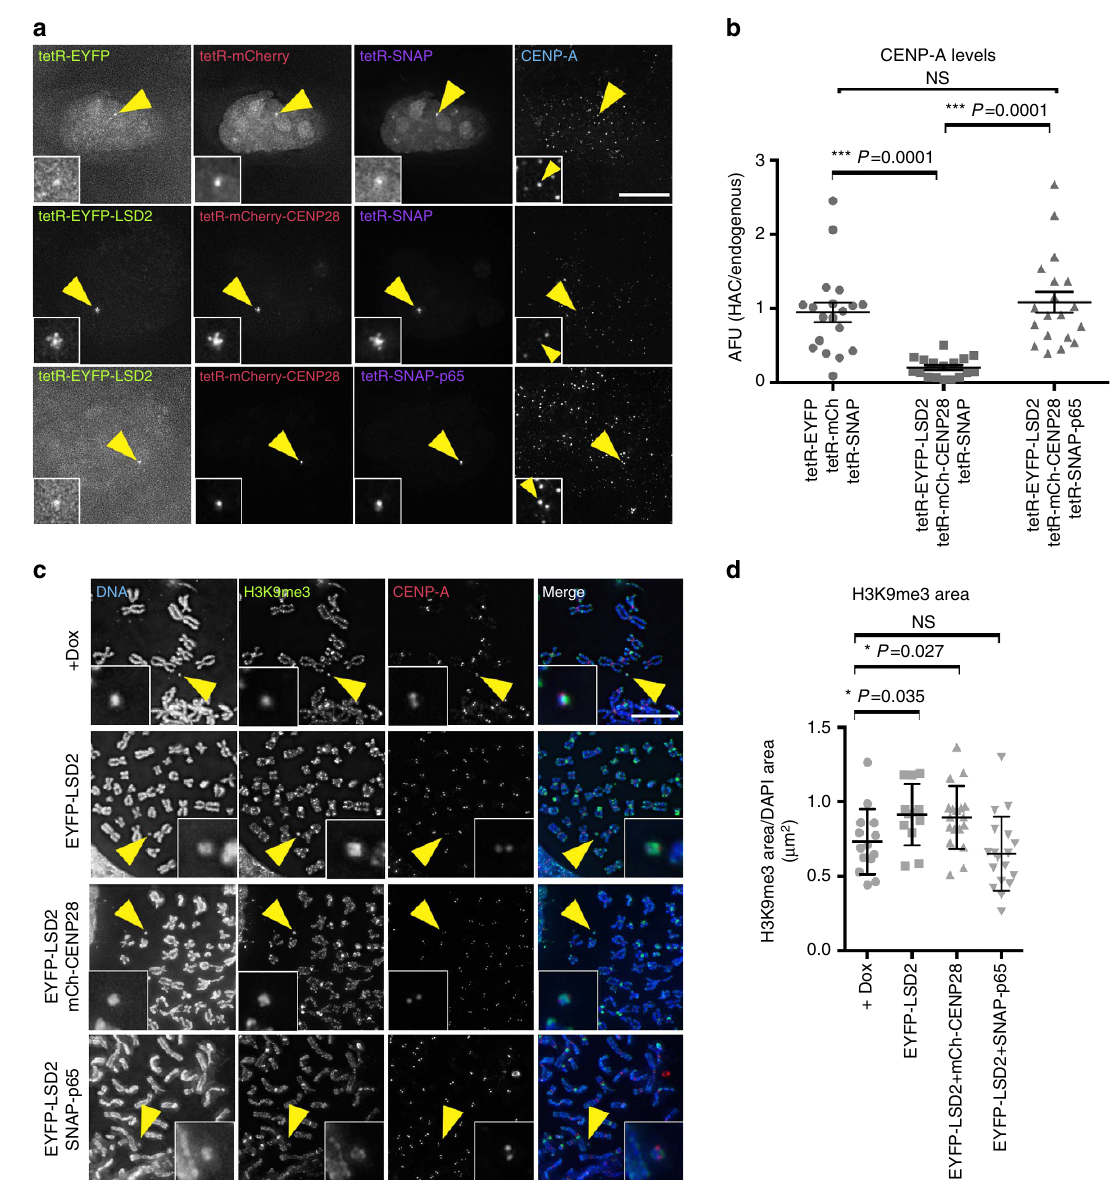
Figure 8 | H3K4me2 and H3K9ac maintain the epigenetic signature of centrochromatin. ( a ) Representative images of 1C7 cells expressing the indicated tetR-fusion proteins for 48h. The tetR-SNAP fusion proteins were detected by incubating cells with SNAP-Cell 647-SiR substrate (panel 3) and CENP-A was detected with Alexa-405-coupled antibodies (panel 4). ( b ) Quantification of fluorescence signals of HAC-associated CENP-A staining in individual cells transfected with the indicated tetR-fusion constructs. Values for the HAC-associated CENP-A were normalized for the mean of CENP-A signals on endogenous chromosomes. ( c ) Representative images of 1C7 metaphase spread expressing the indicated tetR-fusion proteins for 4 days. Metaphase chromosomes were stained with DAPI, CENP-A and H3K9me3. Arrowheads depict the HAC. ( d ) Quantification of the area occupied for H3K9me3 in the HAC normalized for the DAPI area in the presence of doxycycline (no tetR-EYFP binding) and after 4 days of expression of the indicated tetR-fusion proteins. Asterisks indicate significant differences (* P o 0.05; ** P o 0.01; Mann–Whitney’s test). Solid bars indicate the medians and error bars represent the s.e.m. N ¼ two independent experiments. Scale bars, 10 m